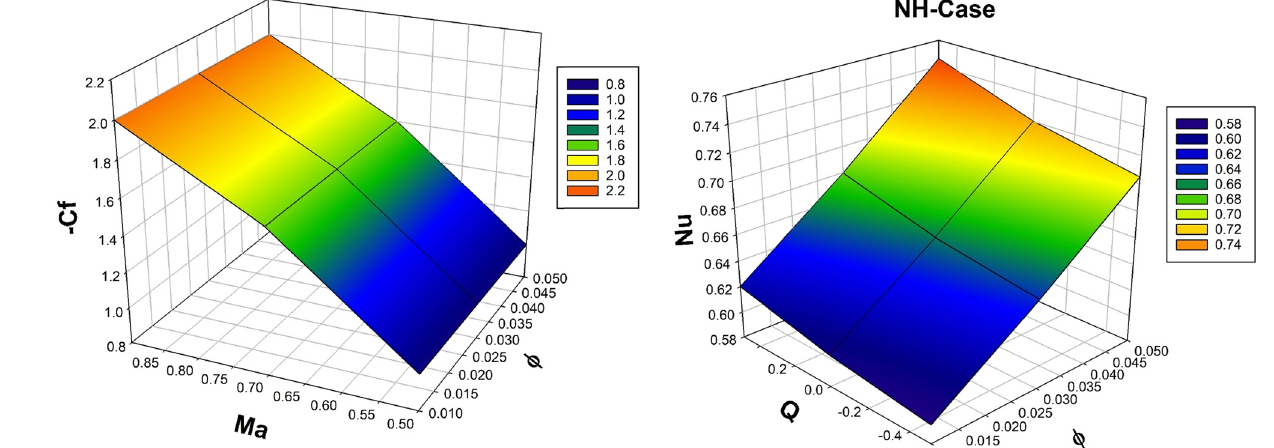
Figure 13: Change in Nu against Q for heightening of ϕ ( NH case )